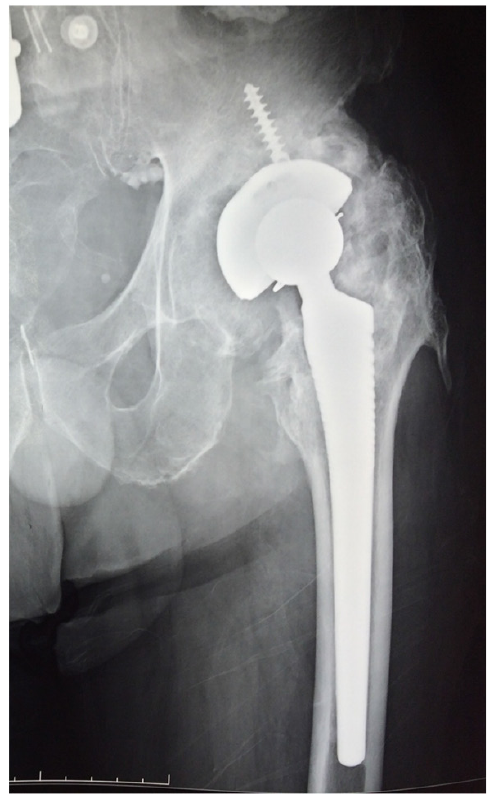
Figure 1: Preoperative anteroposterior radiograph of the left hip shows the infected THA and the adjacent heterotopic ossification.